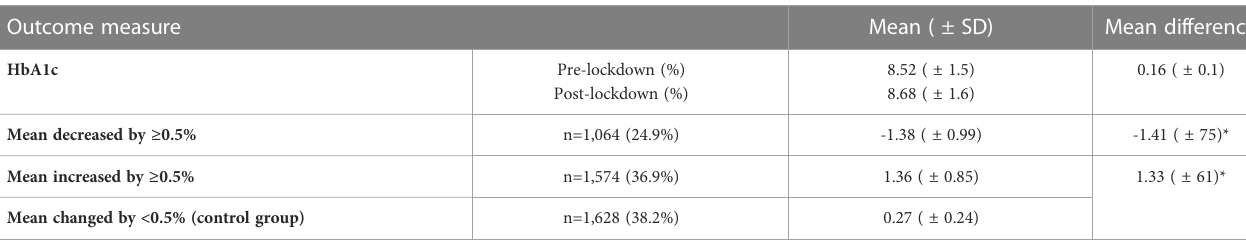
TABLE 2 HbA1c scores throughout pre to post COVID-19 lockdown and subgrouping of the cohort based on the score changes beyond the clinically signi fi cant cut-off point (0.5%). Outcome measure HbA1c